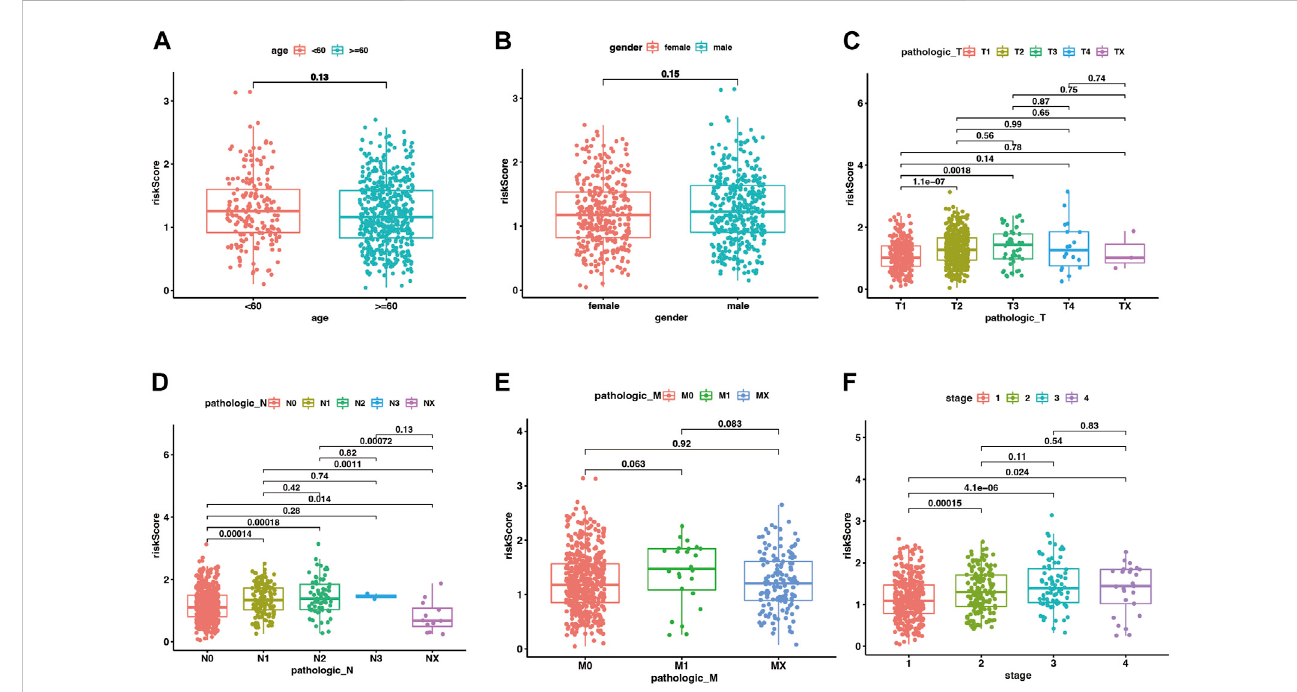
FIGURE 4 The distribution of risk scores between different clinical subgroups in the merge cohort. (A – F) corresponded to two age groups ( < 60 vs. ≥ 60 years), gender (male vs. female), Tumor classi fi cation, node classi fi cation, metastasis classi fi cation, and stages. p < .05 was considered signi fi cant.